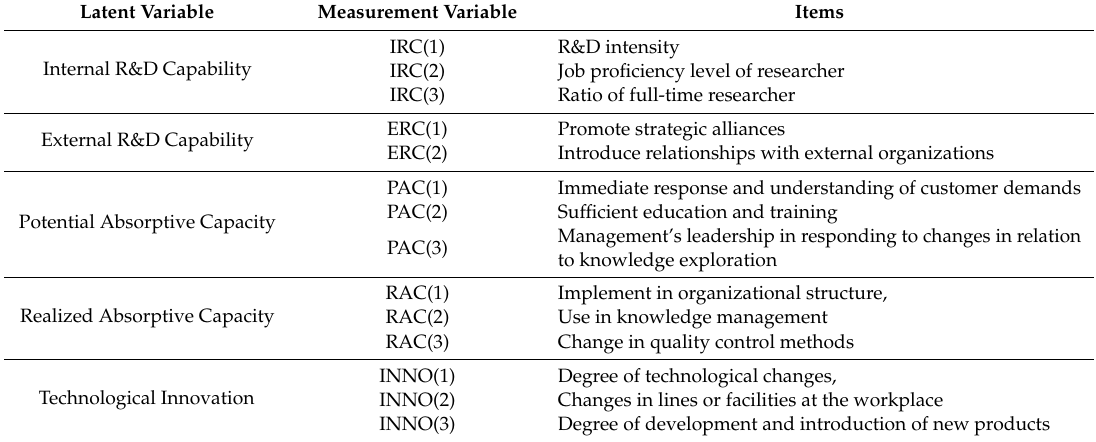
Table 3. Variables and